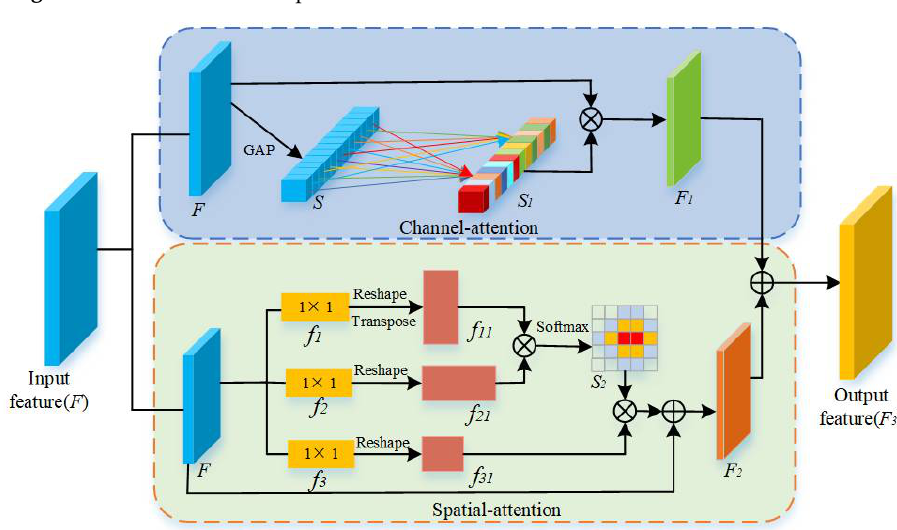
Figure 4. The structure of improved YOLOX-Nano.